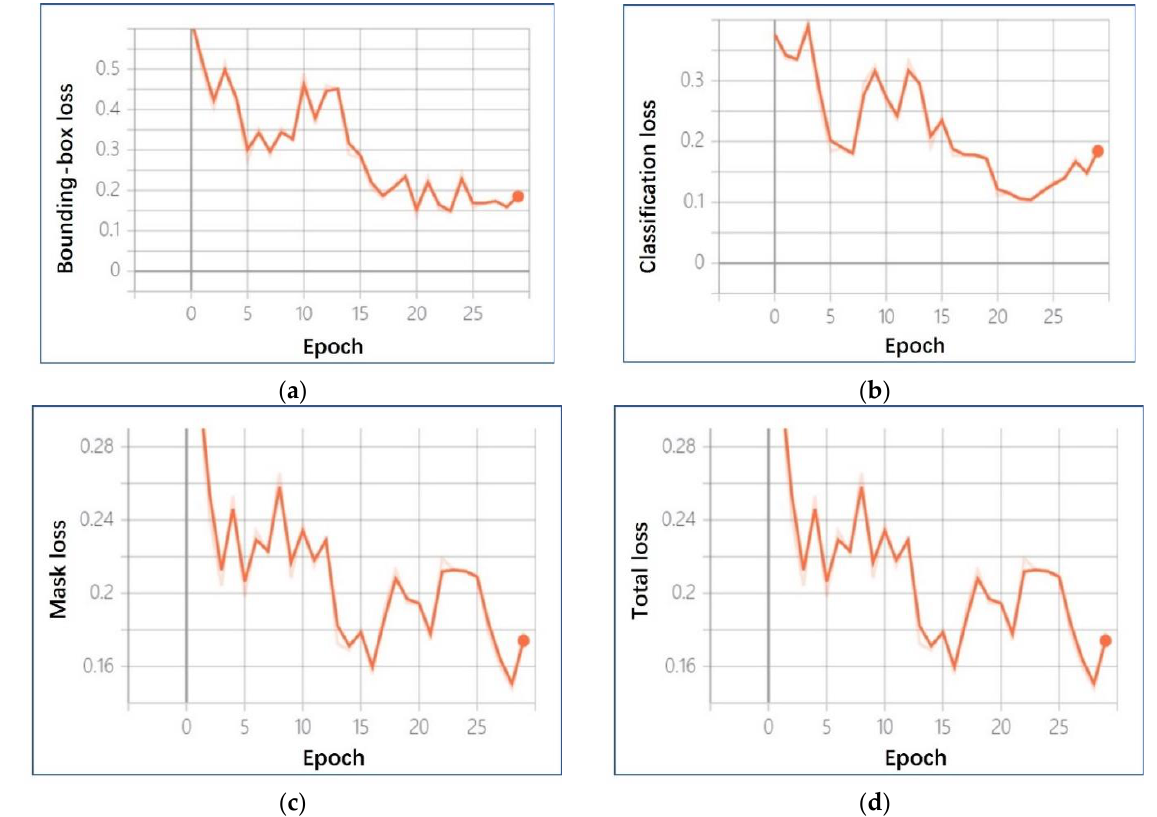
Figure 5. Test effect after model training. ( a ) The bounding-box loss; ( b ) The classification loss; ( c ) The mask loss; ( d ) The total loss.